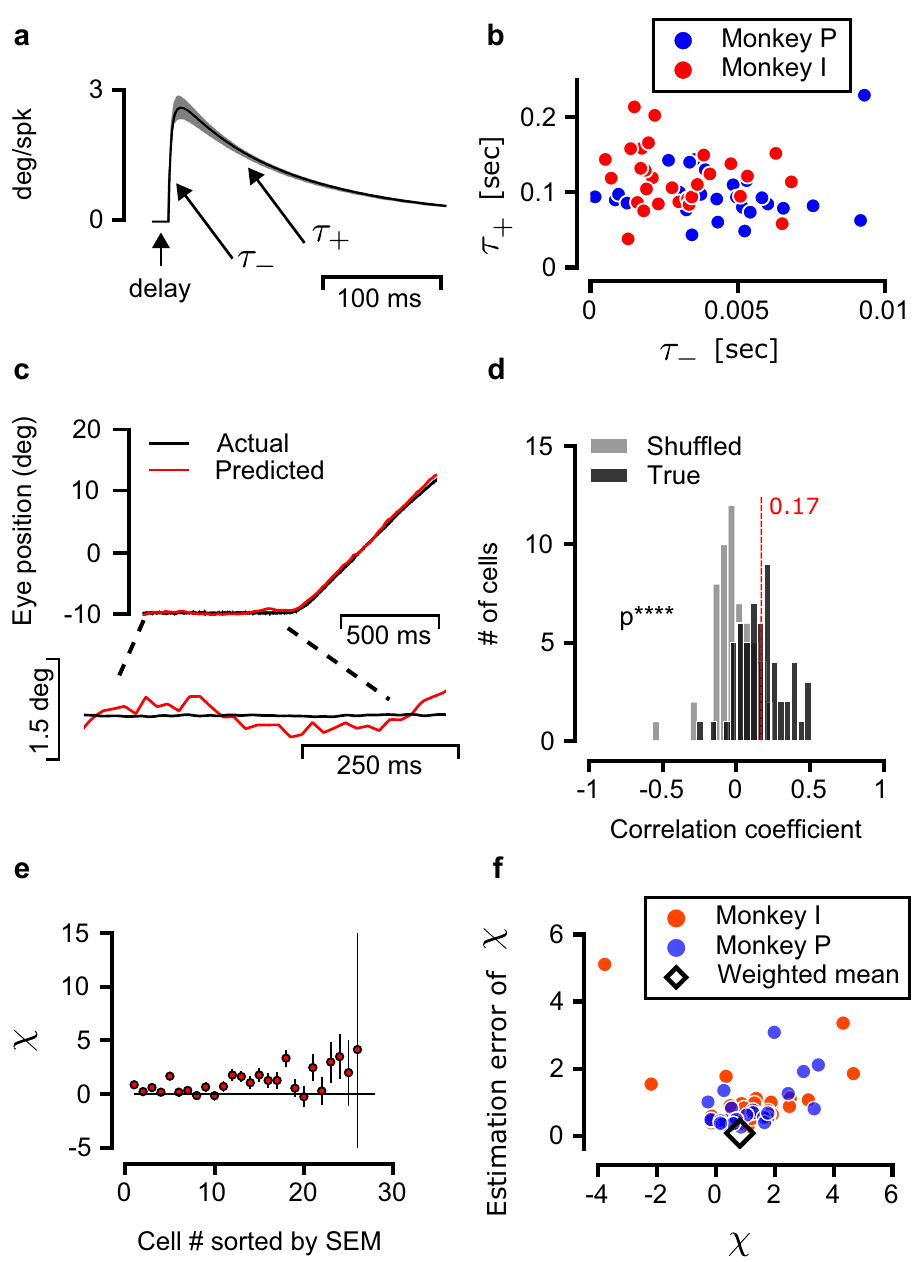
Fig. 2 Predicting the eye trajectory from OMN spikes. a Double exponent kernel as fi tted from the data, black and gray traces represent the mean and SEM over all kernels optimized. b Fast ( τ − ≈ 5 ms) and slow ( τ + ≈ 120 ms) time constants of the fi tted kernels, shown for all analyzed OMNs (excluding one cell with τ − = 0.01 s and τ + = 0.79 s). c Actual and predicted eye position during a single trial. Lower panel, zoom in on fi xational segment. The predicted eye position, based on the spikes, was obtained using eqs. (4) – (7) (Methods). Note that the predicted eye position is much more variable than the actual eye position. d Distribution across OMNs of correlation coef fi cients between actual and predicted eye position differences across 350 ms fi xational intervals (black). One sided t test, p = 3.8 × 10 − 12 ( n = 57 OMN cells. Number of fi xational segments varied from cells to cell and was 302 on average. Histogram shown in Extended Data Fig. 7c). Gray, distribution of correlation coef fi cients obtained from each OMN after shuf fl ing (see Methods). e For each OMN of monkey I we estimated χ from the data, which is the fraction of measured eye position variance that can be attributed to a central source upstream of the OMNs. Cells ( N = 26 shown) are sorted along the horizontal axis by the estimation error of χ . Circles represent the estimates of χ (eq. (15). Error bars extend above and below the circles by Δ χ , where Δ χ is the standard error of the estimate, as described in Methods. The horizontal black line is χ = 0 for reference. Note that while χ is expected to lie within the range [0, 1], our estimates for this quantity based on eq. (15) are noisy, due to the OMN spiking noise and the limited number of trials for each cell. Therefore, these estimates can deviate from the expected range. For visual clarity, two cells with χ = 73 ± 37, 44 ± 41 are not shown. f Distribution of both χ (horizontal-axis) and its estimated error (vertical-axis), from OMNs recorded in the two monkeys. Black diamond: weighted average of the results from both monkeys (see also Methods) indicates that a large fraction in the variance is attributed to a central source, 〈 χ 〉 = 0.82± 0.07 (weighted mean ± weighted